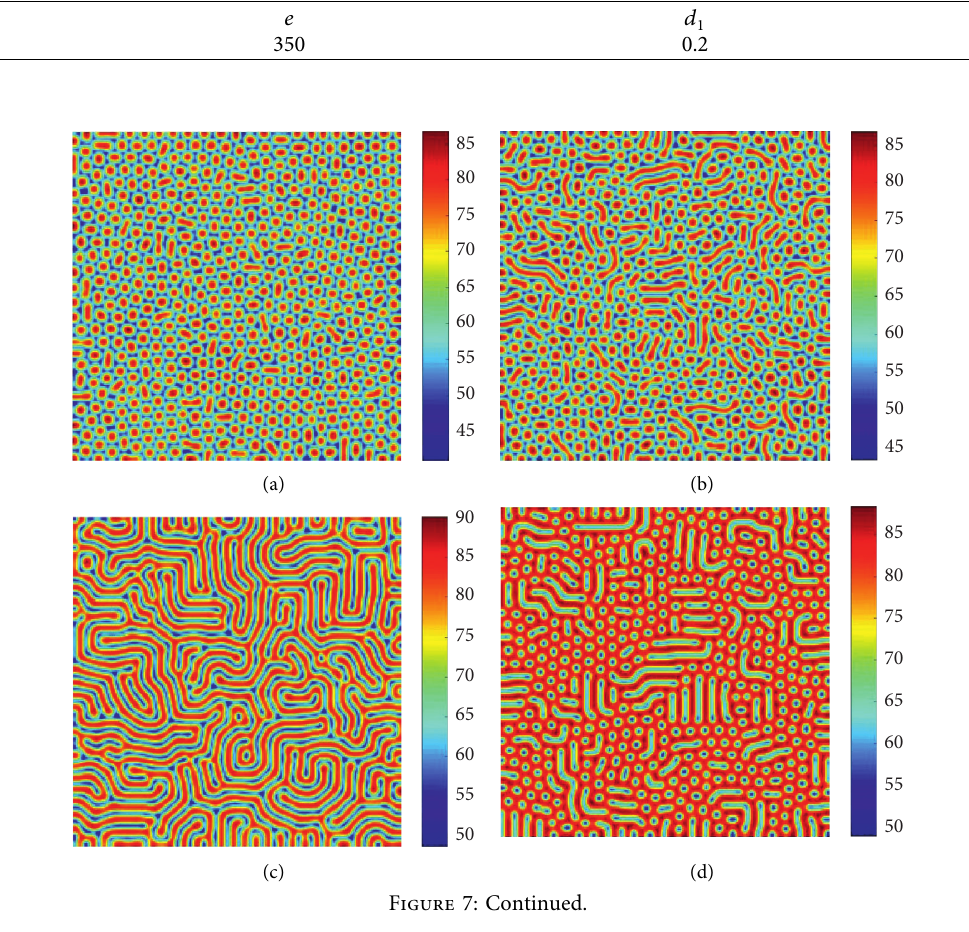
Figure 6: The iterations of stripe patterns of the predator with 31 � 0.83. The number of iterations is (a) 0, (b) 3600, (c) 130000, and (d) 150000. Table 6: The parameters selected in system